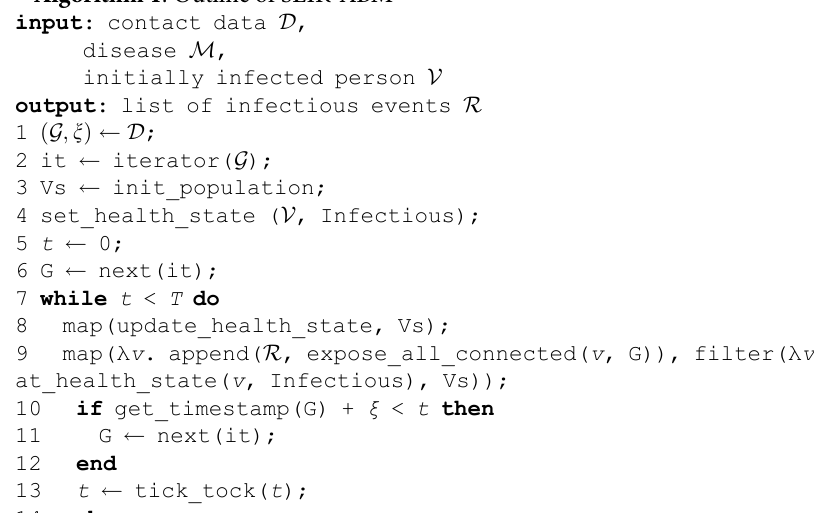
Algorithm 1 : Outline of